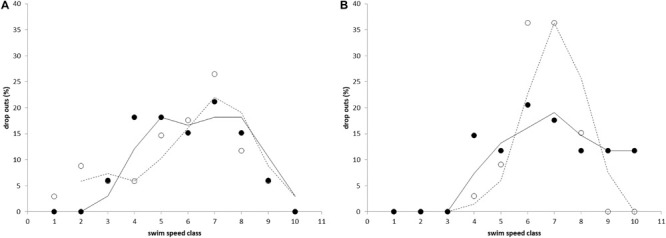
The percentage of fish that fatigued and dropped out during the critical swimming speed test for (A) Atlantic salmon and (B) Gilthead seabream. Percentage of drop outs is shown vs. swim speed classes (10 size classes of 5 cm s–1 in a range of 70–120 cm s–1) and indicates normal distributions of data. Results of both tests (filled and non-filled circles, and lines and dashed lines for the first and second test, respectively) are similar.